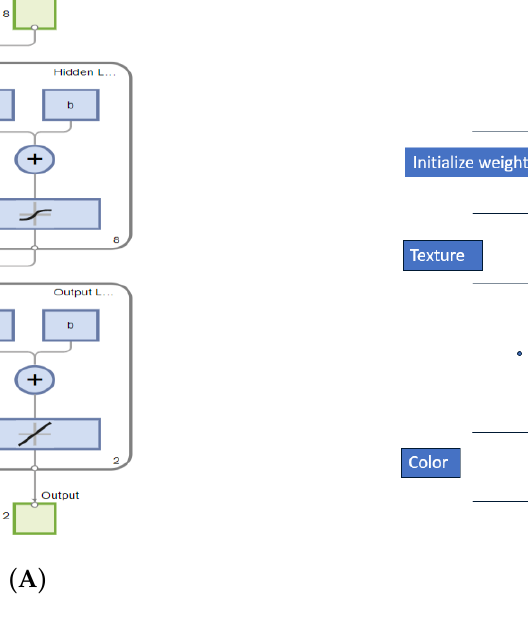
Figure 9. ( A ) BP neural network structure diagram; ( B ) BP neural network topology.